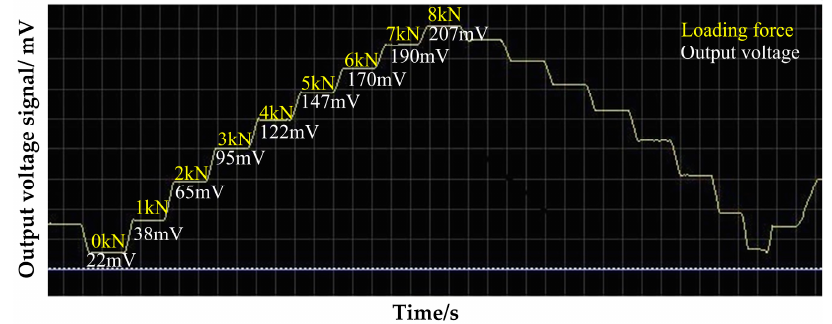
Figure 7. The output interface of the stress detection system.